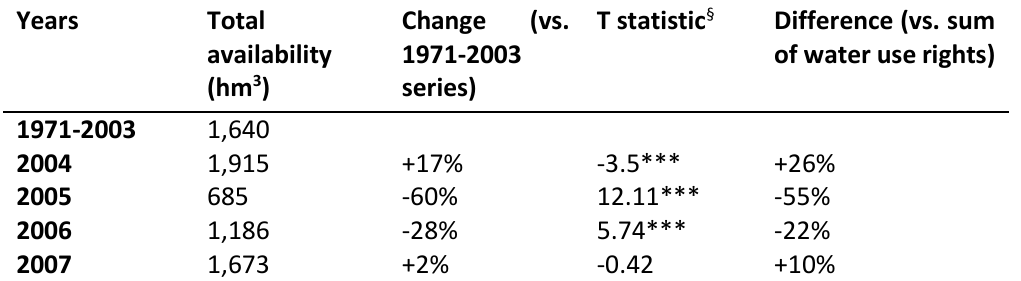
Table A1.1 Univariate sample test of total reservoir water entries (October to